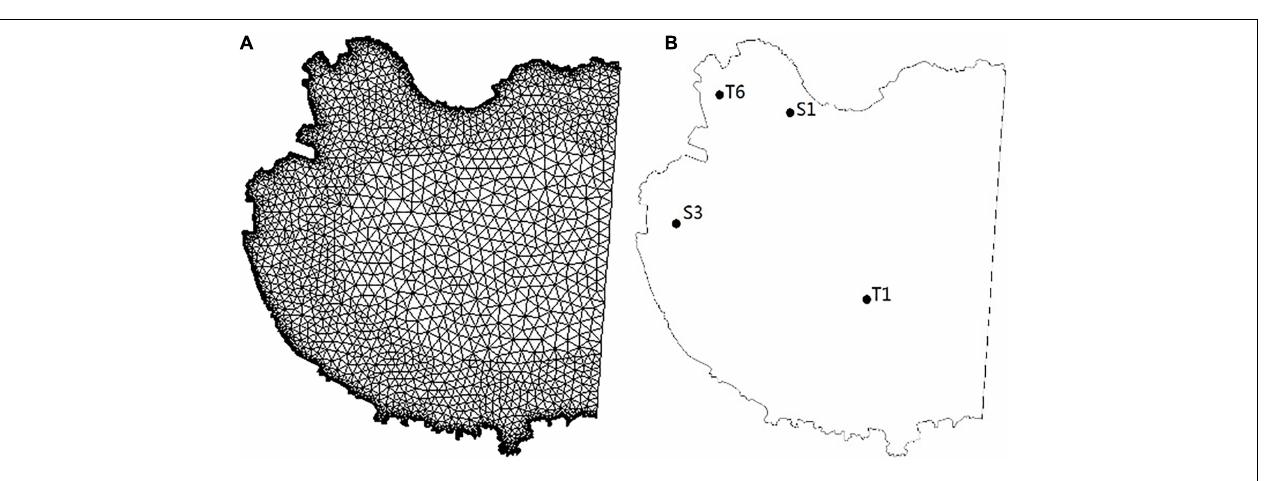
FIGURE 2 | Mesh partition of the hydrodynamic model and tidal current observation points in Bohai Bay. (A) Mesh partition. (B) Observation